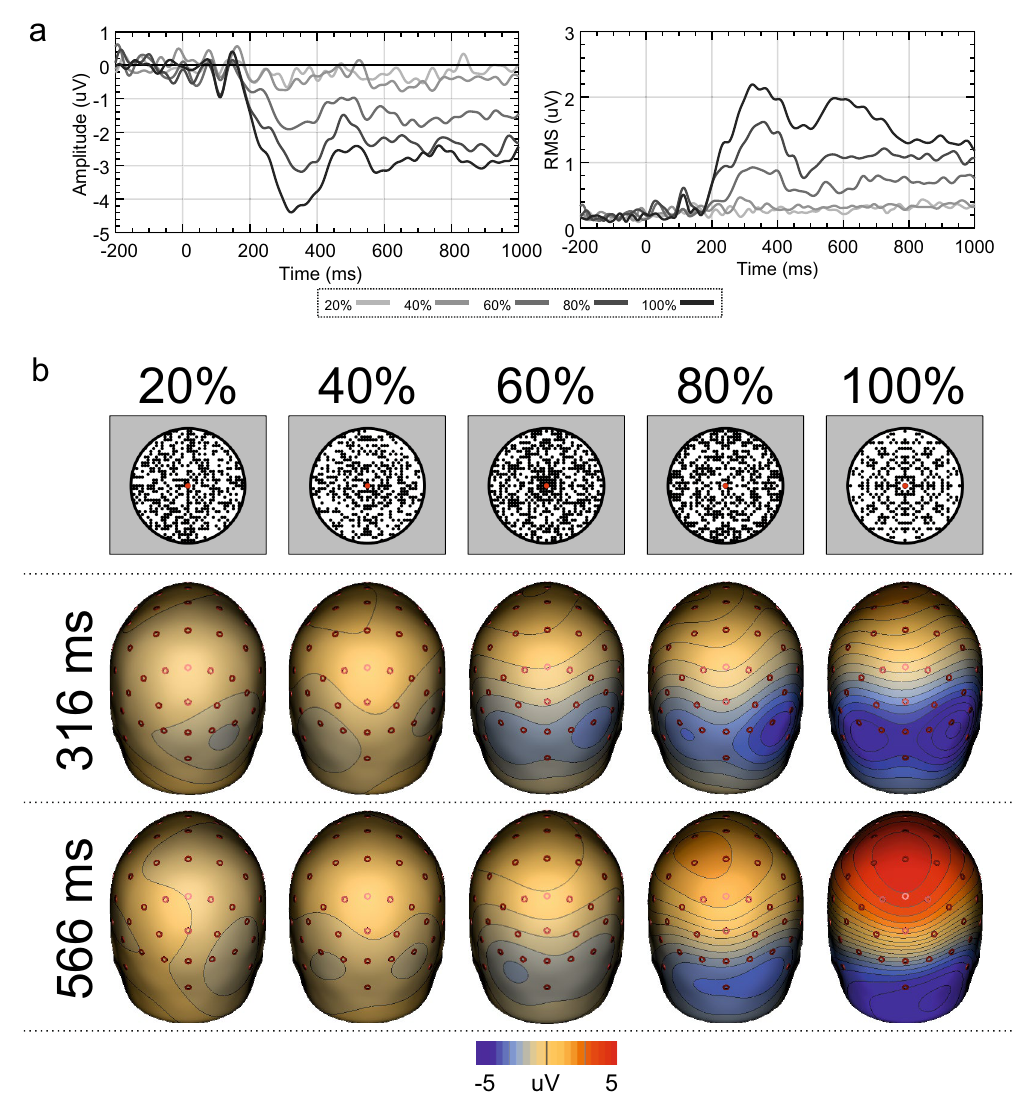
Figure 10. ERP, GFP, scalp maps and stimuli from Palumbo et al. 32 . ( a ) Mean activity at electrodes PO7, PO8, O1 and O2 and GFP across all electrodes for the different levels of PSYMM obtained from a reanalysis of Palumbo et al. 32 . ( b ) Scalp maps at the peak activity within the GFP, alongside the stimuli used in this experiment. Scalp maps were created using BESA 7.0 (https